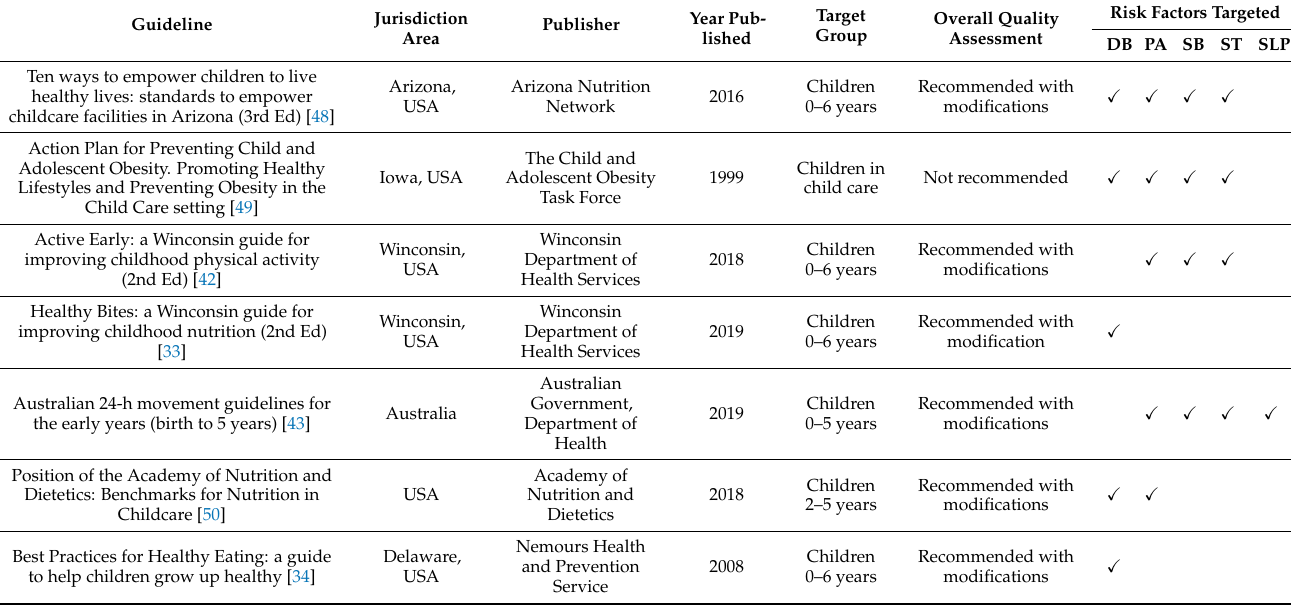
Table 1. Characteristics Table of Included